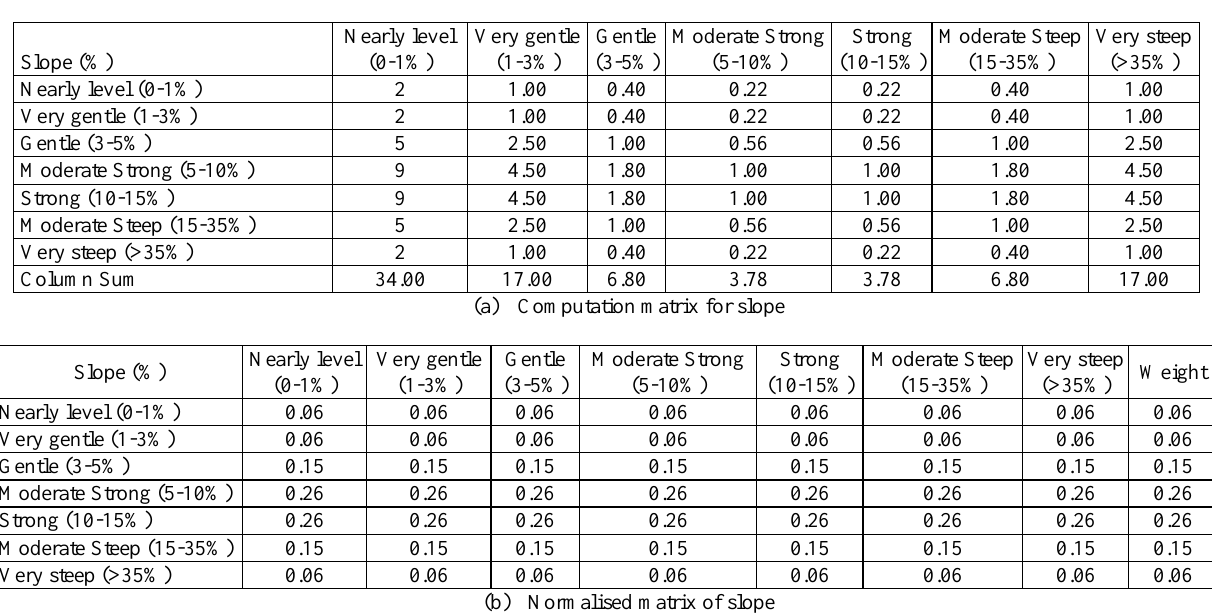
Figure 8. Slope percent weightage map